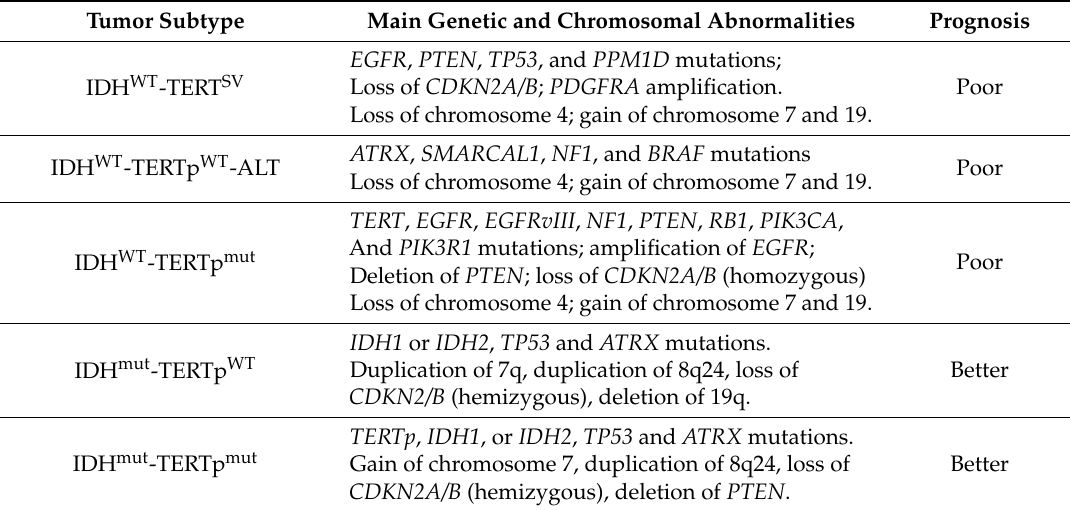
Table 3. Subdivision of glioblastomas in molecular subgroups according to the presence of TERT abnormalities (including TERT promoter mutations, TERTp mut and TERT gene structural variants, TERT SV ), IDH1 or IDH2 mutations ( IDH mut ) and the presence of genetic abnormalities conferring